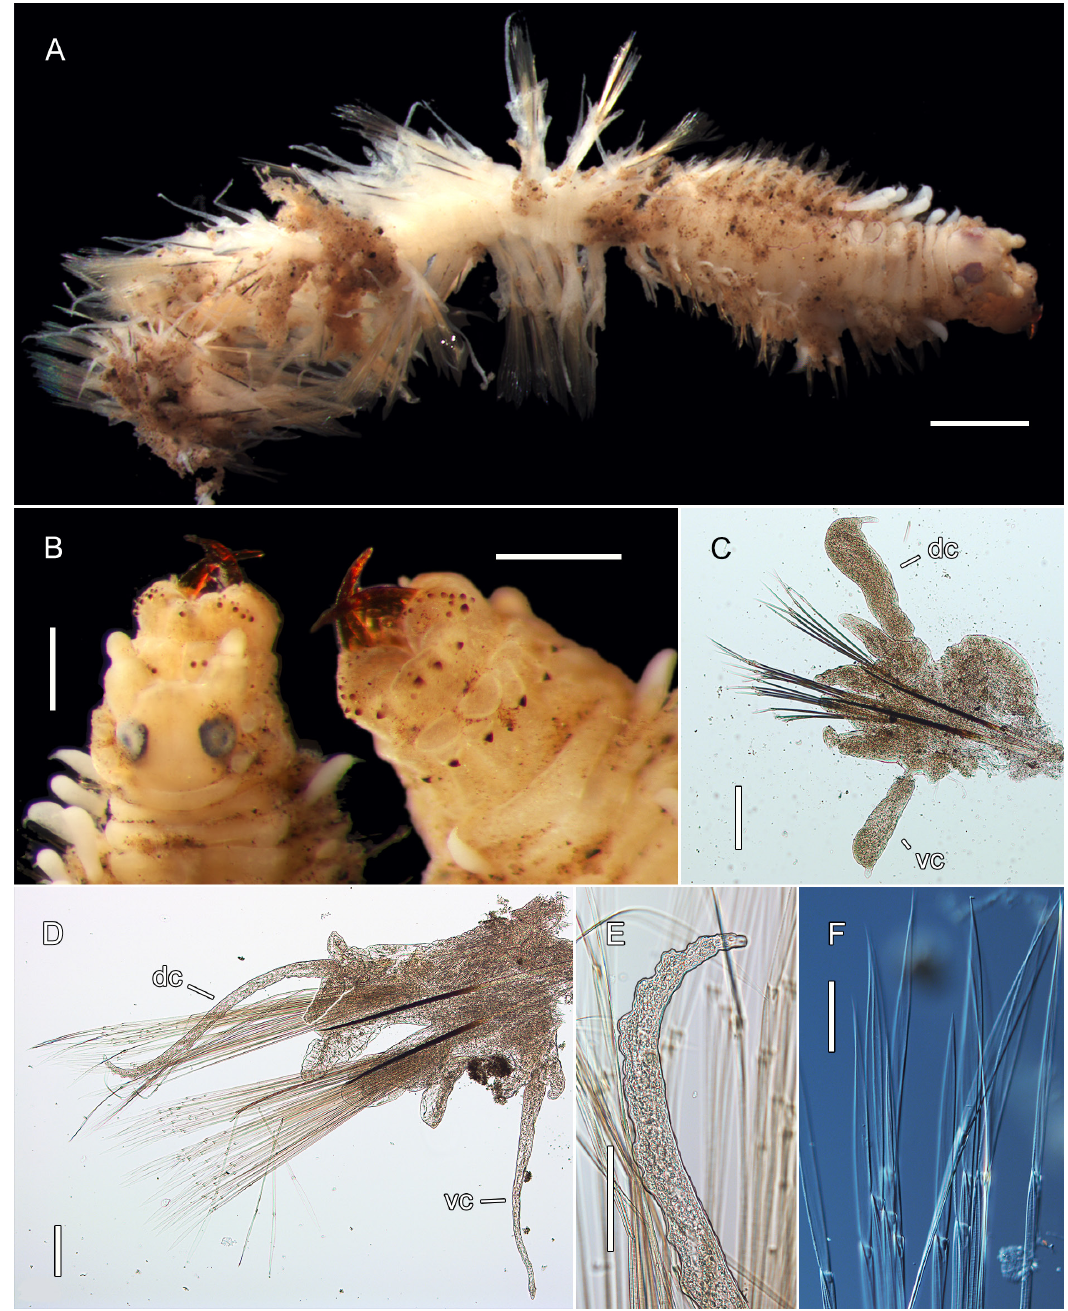
Fig. 6. Neanthes goodayi sp. nov., epitoke paratype (NHM_1783), preserved specimen. A . Entire specimen, dorsal view. B . Extruded pharynx, dorsal view (left), ventral view (right). C . Detail of pre- natatory parapodium 4, with modified dorsal and ventral cirri, posterior view. D . Detail of modified natatory swimming parapodium, chaetiger 31, posterior view. E . Detail of papillated dorsal cirrus, chaetiger 31, posterior view. F . Modified swimming spinigers, subacicular neurocheatal fascicle, chaetiger 32. Abbreviations: DC = dorsal cirrus; VC = ventral cirrus. Lobe at base of dorsal cirrus in D and E outlined with a fine white or black line. Parapodium in C dissected from left side of specimen; parapodium in D dissected from right side of specimen, with images D and E laterally inverted to follow direction of other plates. Scale bars: A = 1 mm; B = 500 µm; C–D = 200 µm; E = 100 µm; F = 50